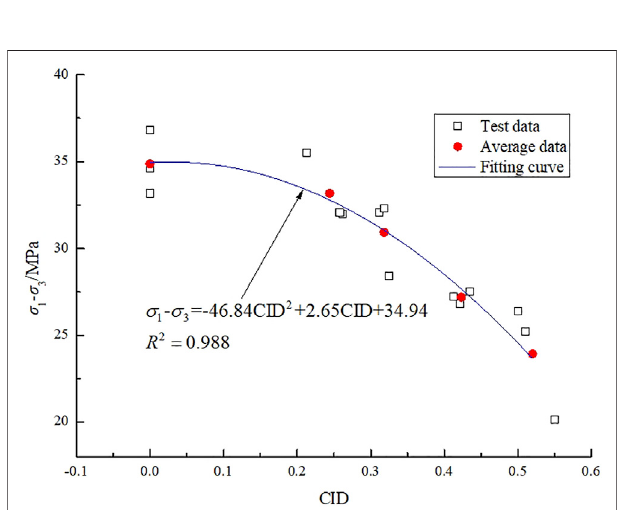
FIGURE 8 | Relationship curve between the peak strain of coal samples and the